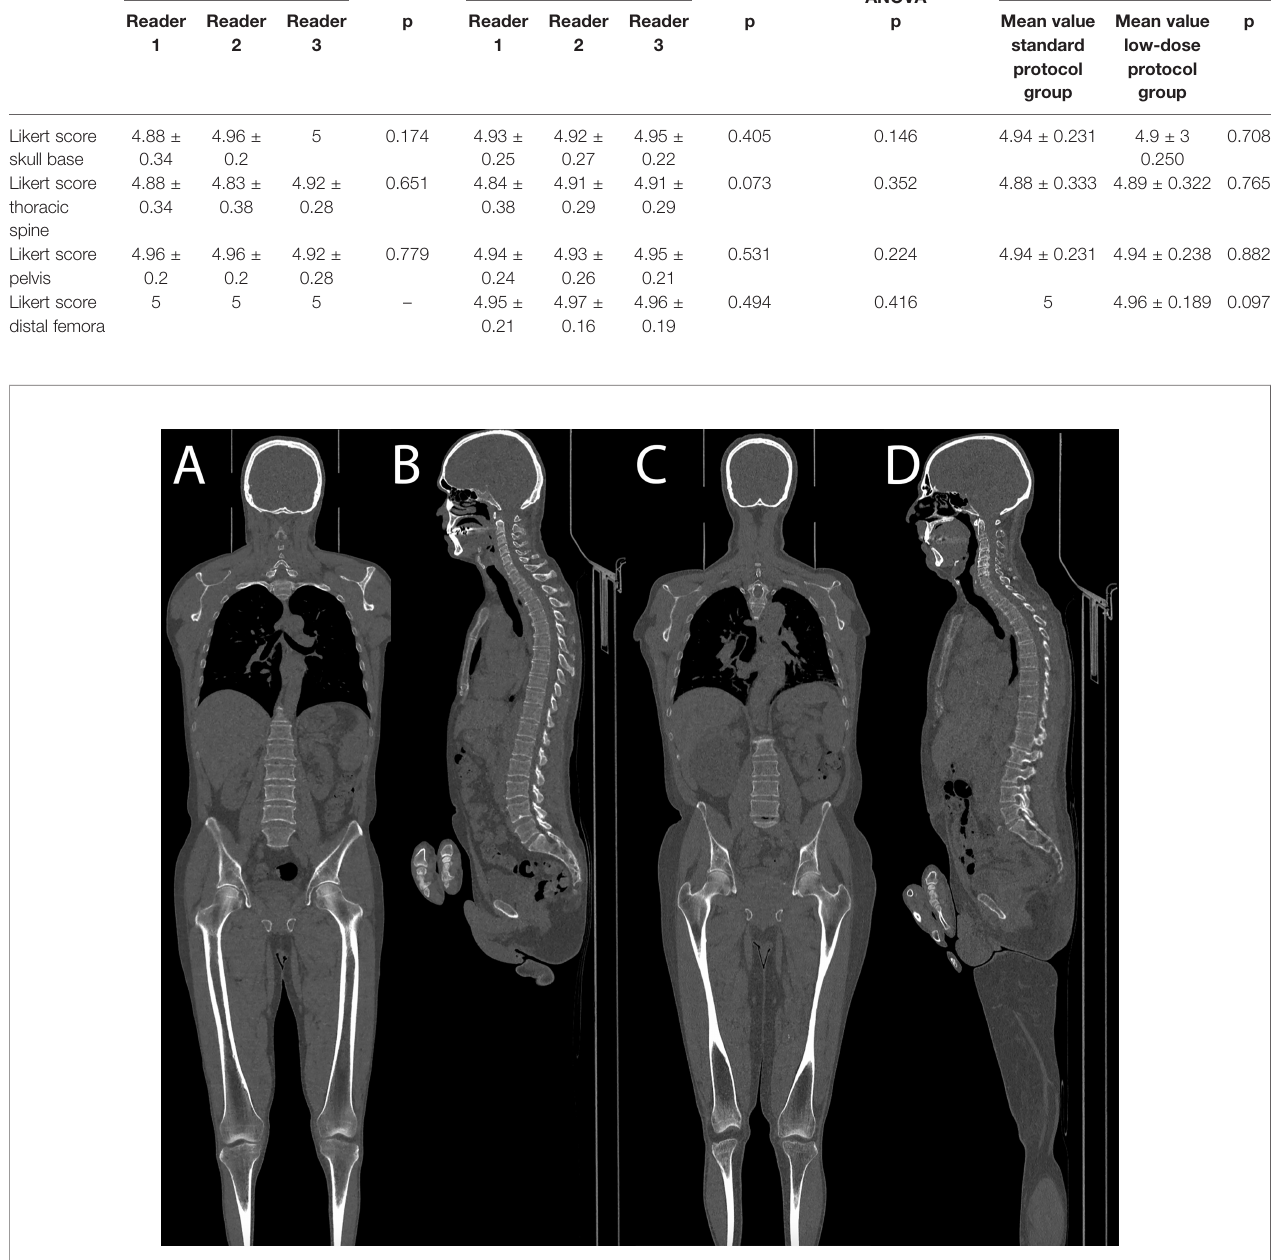
TABLE 2 | Image quality scores of patients ’ datasets. Likert score of image quality of patients ’ datasets Group 1 standard protocol Repeated measures